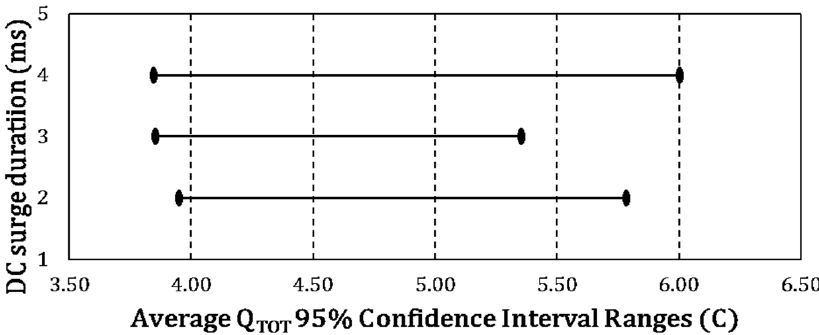
Figure 6. WX manufacturer visual comparison of confidence interval ranges.